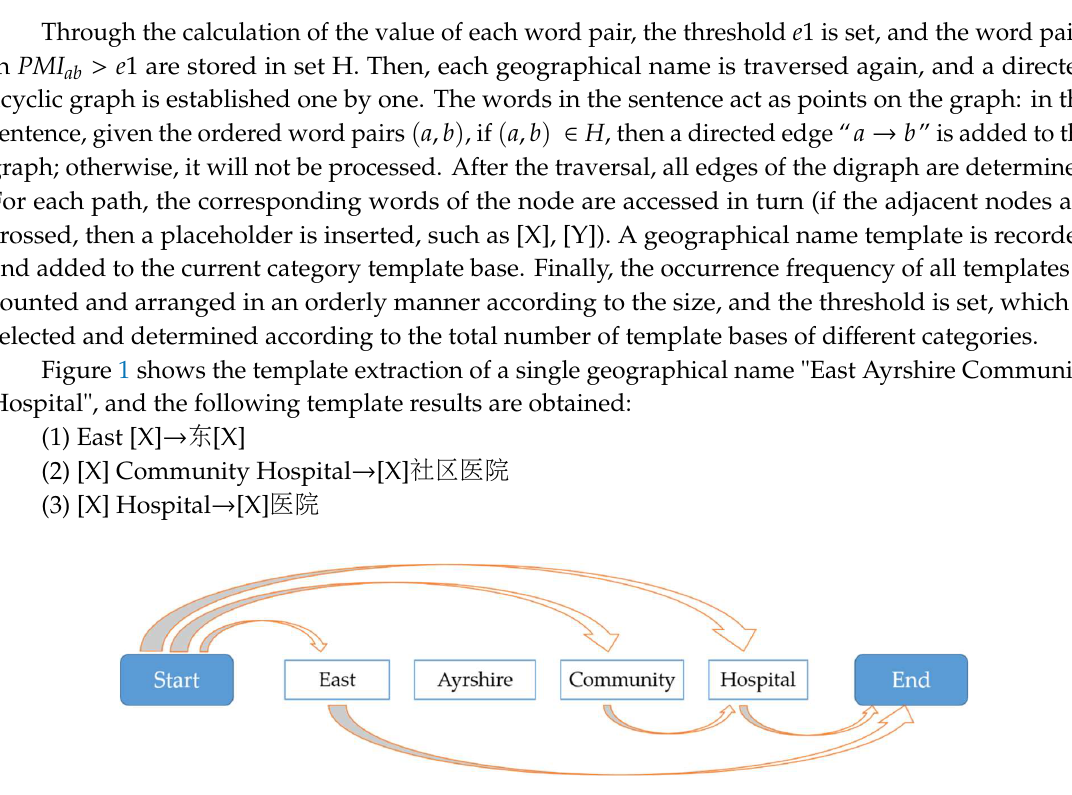
Figure 1. Template extraction diagram of the geographical name.